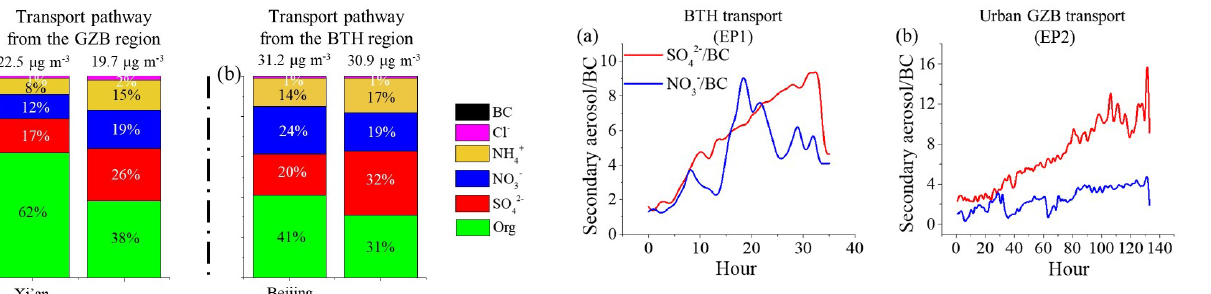
Figure 5. The relationship between production of the secondary inorganic aerosol and transport duration in the pollution episodes. EP1 and EP2 represented the pollution episodes caused by the BTH transport and the urban GZB transport,